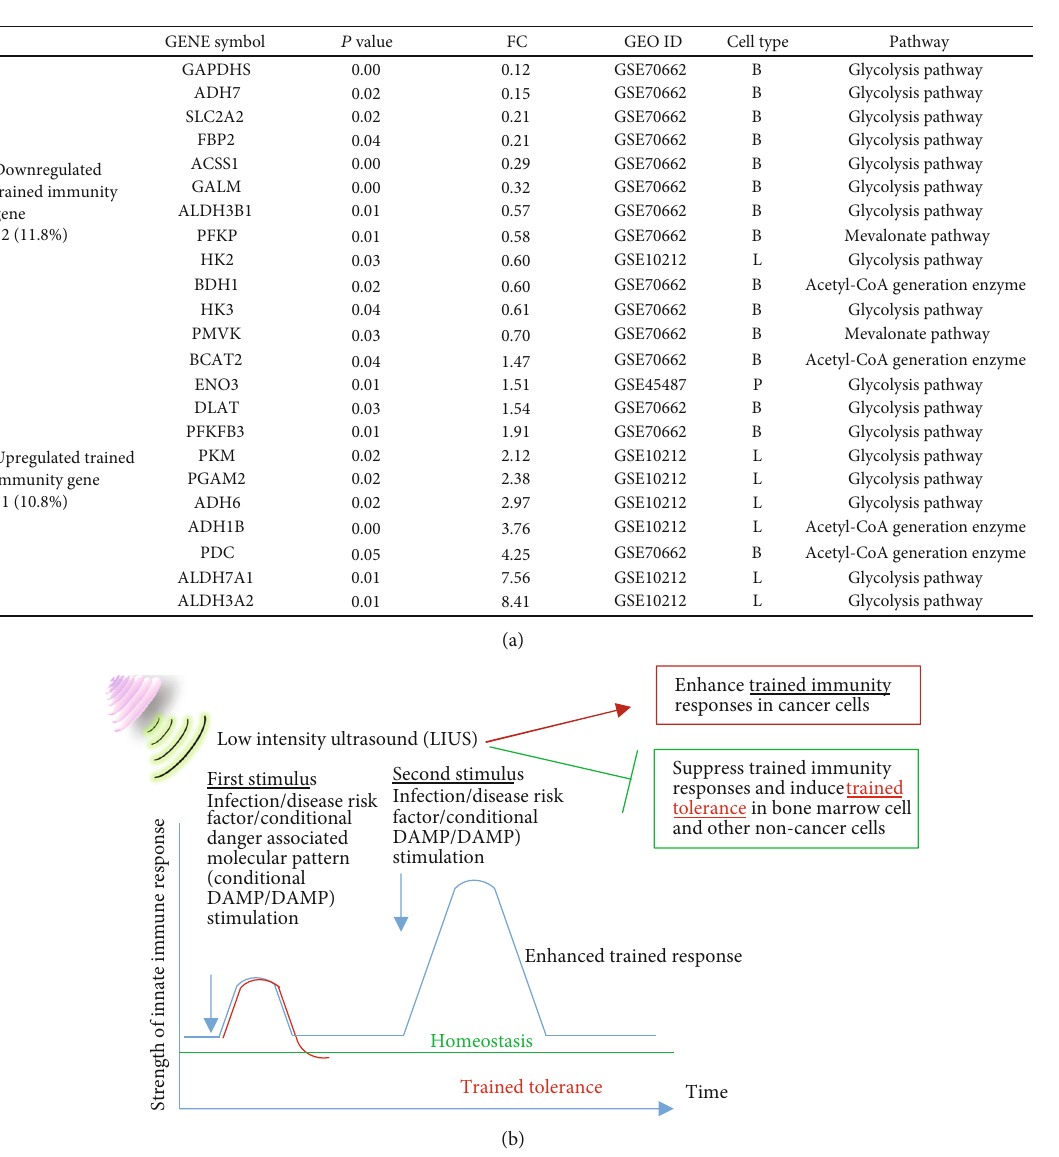
Figure 7: (a) LIUS upregulated trained immunity enzymes in lymphoma cells and downregulated trained immunity enzymes in bone marrow cells, suggesting that LIUS enhances innate immune responses in cancer cells and inhibits innate immune responses in noncancer cells, which are associated with its modulation of trained immunity enzyme expressions. By analyzing microarray data of LIUS-treated human lymphoma cells, mouse preosteoblasts, and rat bone marrow cells, we examined a novel hypothesis that LIUS induces its therapeutic e ff ects in cells by modulating the expressions of our newly reported (PMID: 31153039) innate immune memory (trained immunity) pathway enzymes. Our results show that LIUS downregulates 12 out of 102 trained immunity genes, including 11 (10.8%) in bone marrow cells and one in lymphoma cells. In addition, LIUS induces 11 out of 102 trained immunity genes (10.8%) including 6 in lymphoma cells, 1 in preosteoblasts, and 4 in bone marrow cells. Moreover, in bone marrow cells, LIUS upregulates 4 trained immunity genes and downregulates 11 trained immunity genes including 8 glycolysis enzymes, one acetyl-CoA enzyme, and two mevalonate pathway enzymes, suggesting that 2.75-fold more downregulation than upregulation of trained immunity genes in bone marrow cells contributes enzyme in lymphoma cells (6-fold more upregulation than downregulation) contribute signi fi cantly to LIUS-induced innate immunity and downregulated trained immunity enzymes in bone marrow cells. These results suggest that LIUS enhances antitumor